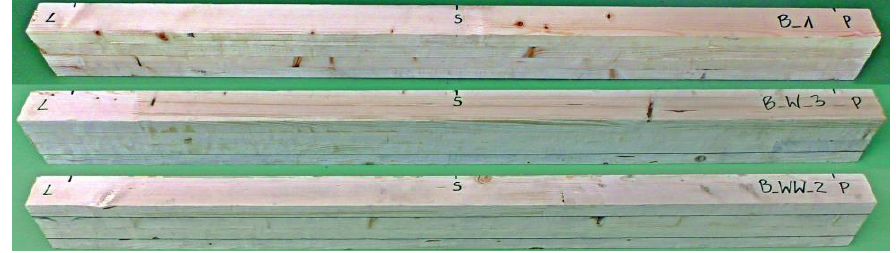
Figure 18. Exemplary “full-scale” girders after planing. Table 3. Average dimensions of the specimens. Notations according to Figure 9 from Section 2. Configuration Type